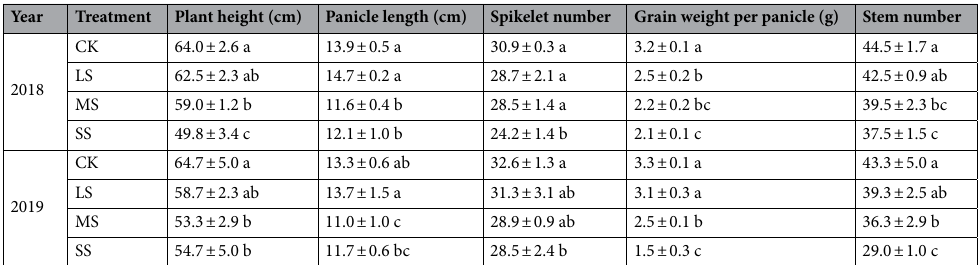
Table 2. Effects of drought stress on the economic characteristics of naked oats. Different letters above the columns indicate significant differences ( P < 0.05) determined by a Duncan’s test between treatments. The same letters above the error bars indicate that there was no significant difference at P >